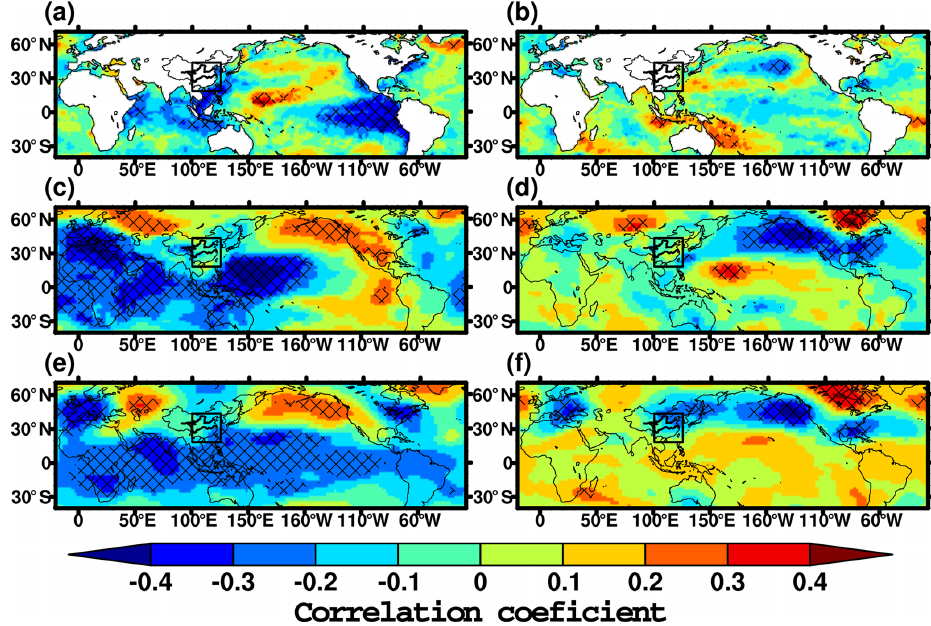
Figure 5. Correlation coefficients in the dry season. (a) Sea surface temperature and PC1, (b) mean sea level pressure with PC1, (c) geopo- tential height at 500hPa and PC1, (d) sea surface temperature and PC2, (e) mean sea level pressure with PC2 and (f) geopotential height at 500hPa with PC2. Hatching denotes the regions with statistical significance at the 95% confidence level. The black rectangle denotes eastern China.